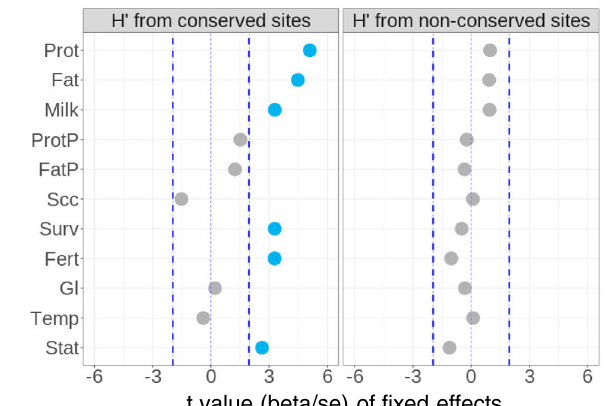
Fig. 1 Directional dominance at conserved sites ( H ’ ) for traits of 104k cows. The beta values and standard errors for each trait were generated using a mixed linear model, fi tting a covariate representing H ’ from 317,279 conserved sites (left panel) and another covariate representing H ’ from the remaining 15,718,164 non-conserved sites (right panel) together with other fi xed effects (e.g. breed). Blue dashed lines indicate t value of − 1.96 and 1.96 commonly used to indicate the signi fi